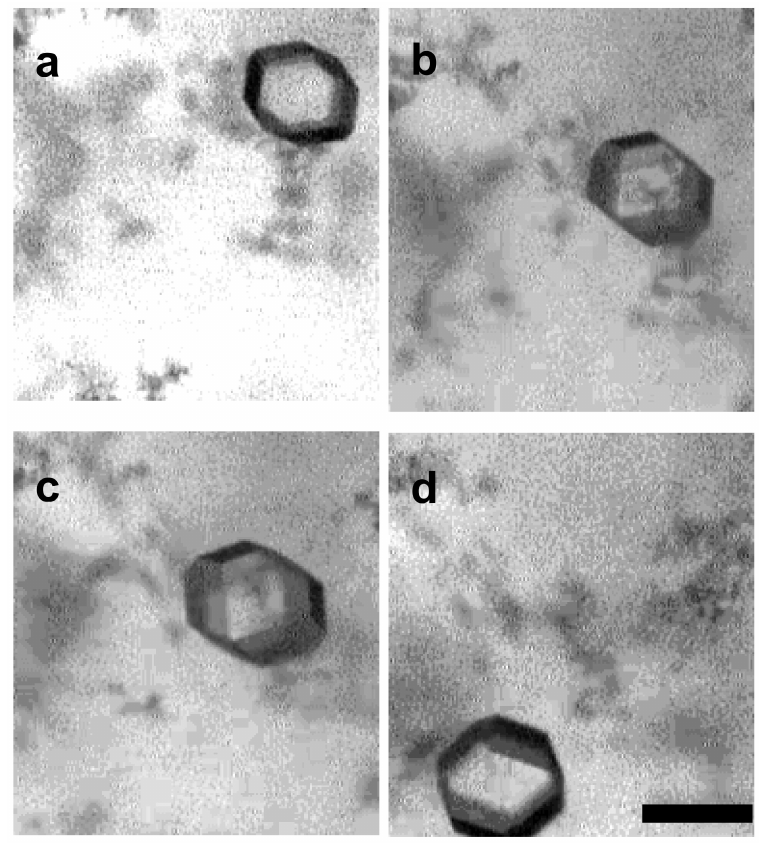
Figure 4. Some images of the same suspending crystal. ( a ) 24.0, ( b ) 42.1, ( c ) 49.4, ( d ) 113.8 h after starting observation. The crystal clearly rotated and moved. Scale bar indicates 100 µ